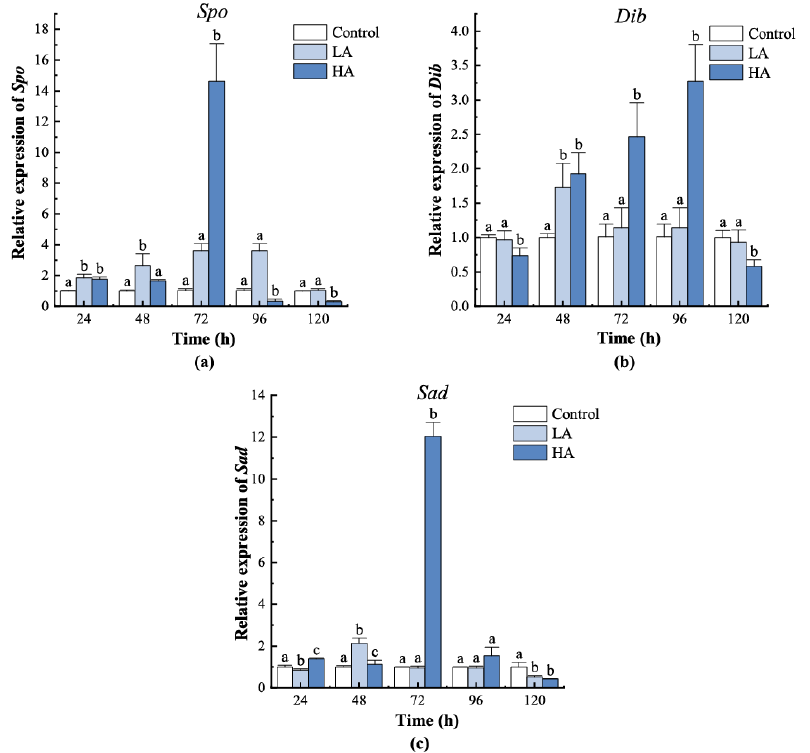
Figure 4. Expression patterns of Halloween family genes in juvenile crabs exposed to ammonia nitrogen stress. ( a ) Spo , ( b ) Dib , and ( c ) Sad . At the same time, the letters indicate significant differences between experimental groups ( p < 0.05).